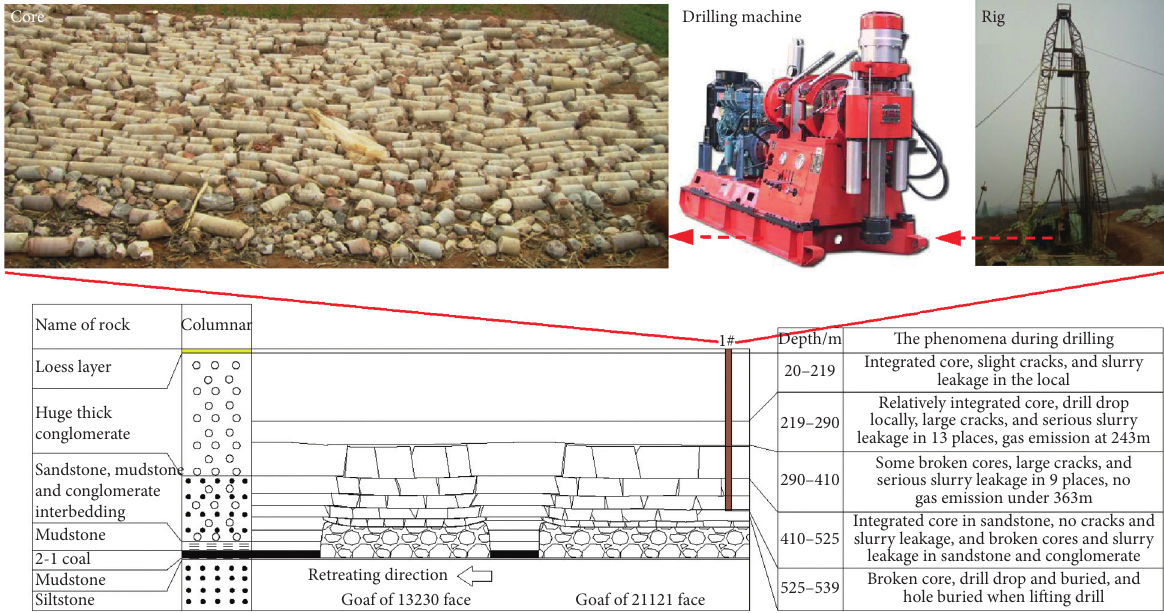
Figure 4: Spatial structure of overburden strata between 13230 and 21121